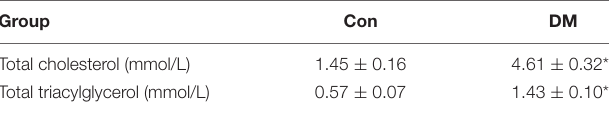
TABLE 1 | Characterization of diabetic animals. Group Con DM Total cholesterol (mmol/L) 1.45 ± 0.16 4.61 ± 0.32** Total triacylglycerol (mmol/L) DM: High-fat-diet-fed streptozotocin-induced type 2 diabetic group. Con: non- diabetic group. Results are expressed as mean ± SD. **P < 0.01 versus Con group; n =